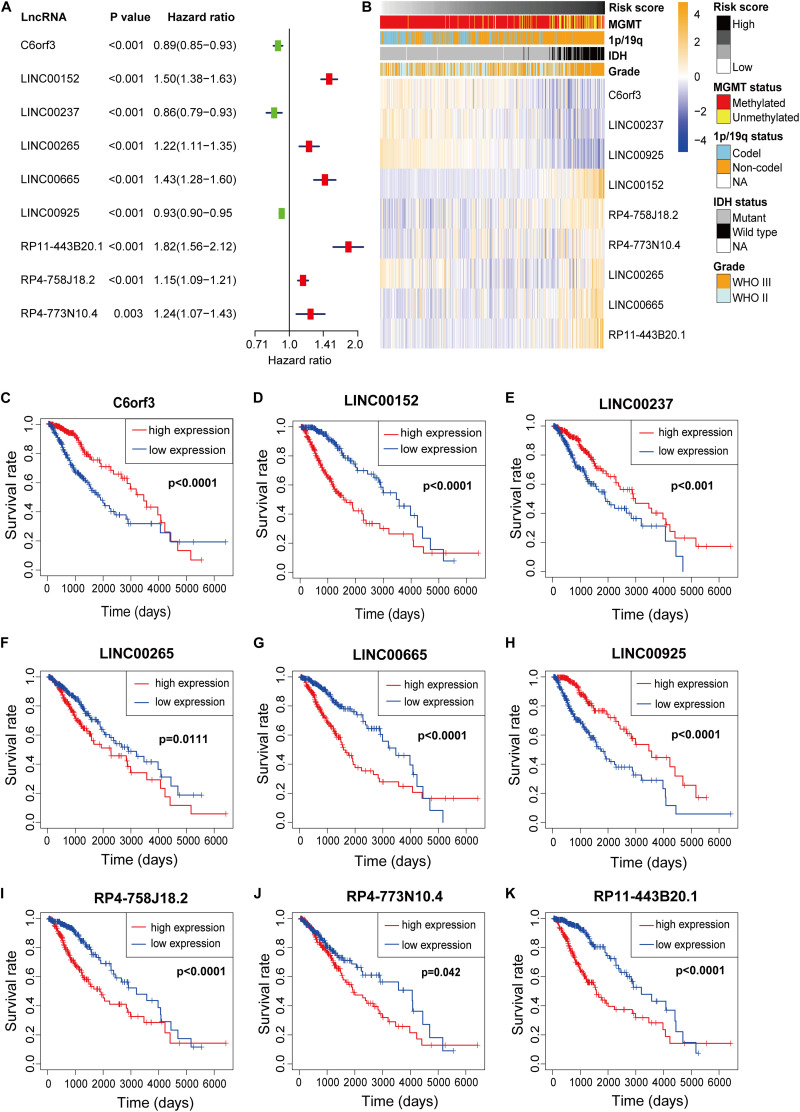
(A) Forest plot of the prognostic ability of the nine m6A-related lncRNAs included in the prognostic signature. (B) Heatmap of the associations between the expression levels of the nine m6A-related lncRNAs and clinicopathological features in the TCGA dataset. (C–K) Kaplan–Meier curves showing that patients with different expression levels of the nine m6A-related lncRNAs had different overall survival.